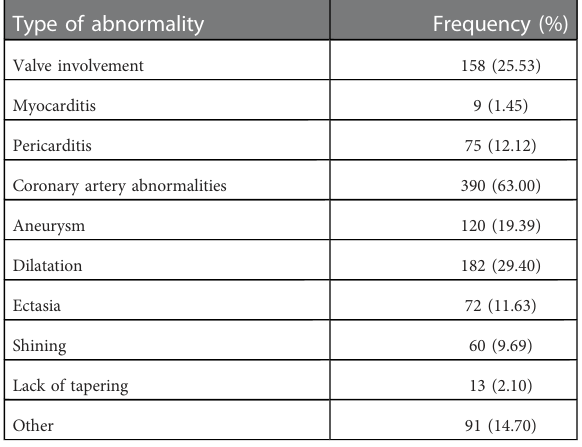
TABLE 2 Echocardiography abnormalities in KD patients suffering from cardiac involvement (N: